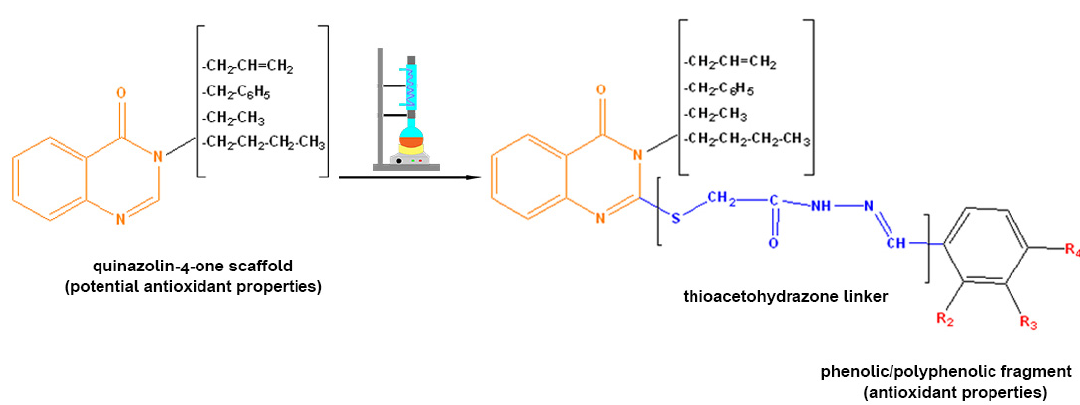
Figure 1. The hypothesis of this